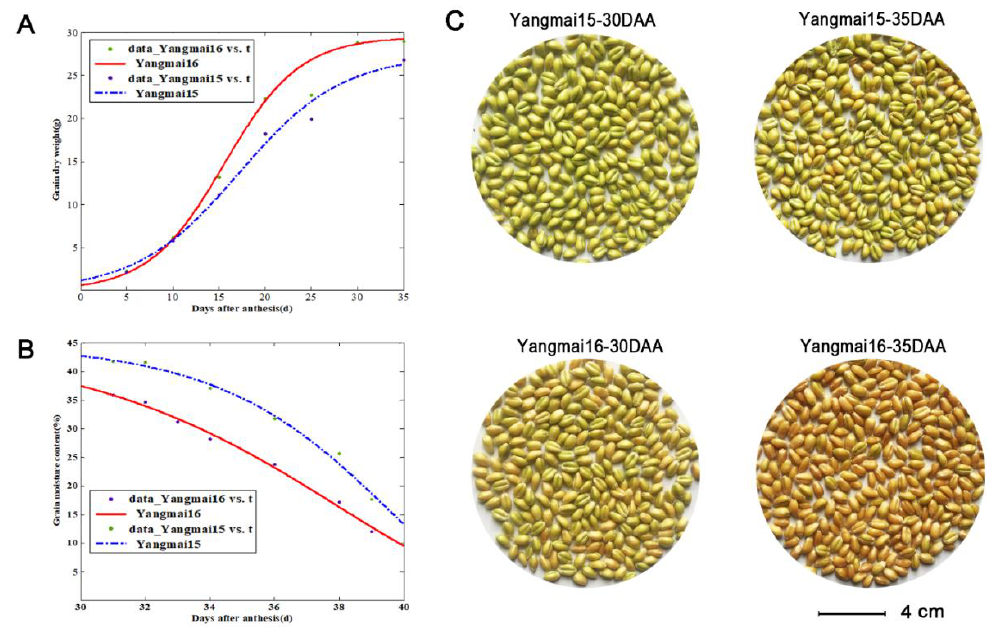
Figure 7. Phenotypic character of grain maturation in Yangmai 15 and Yangmai 16. ( A ), comparison of grain dry weight. ( B ), comparison of grain moisture content. ( C ), appearance of grains during maturation progress; Bar = 4 cm.